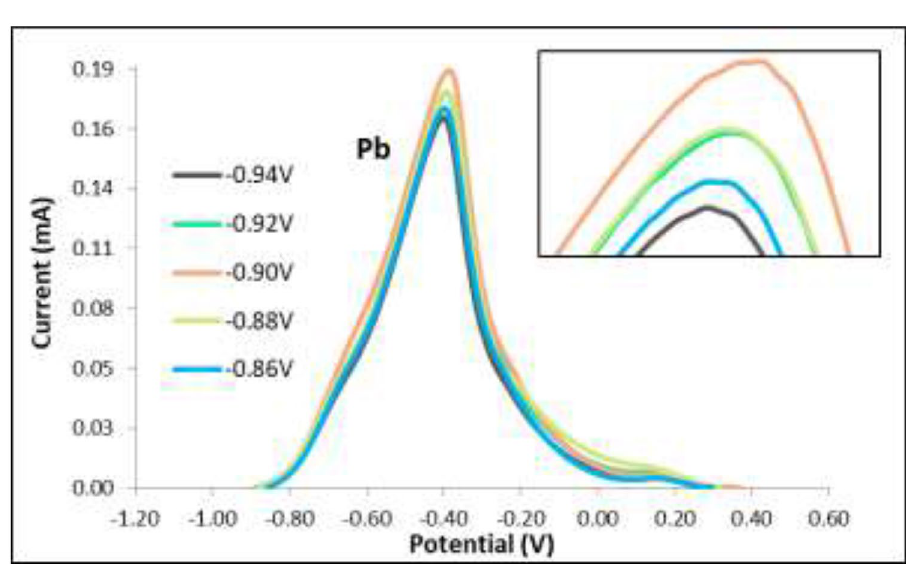
Figure 8. Voltammograms for varying initial potential.